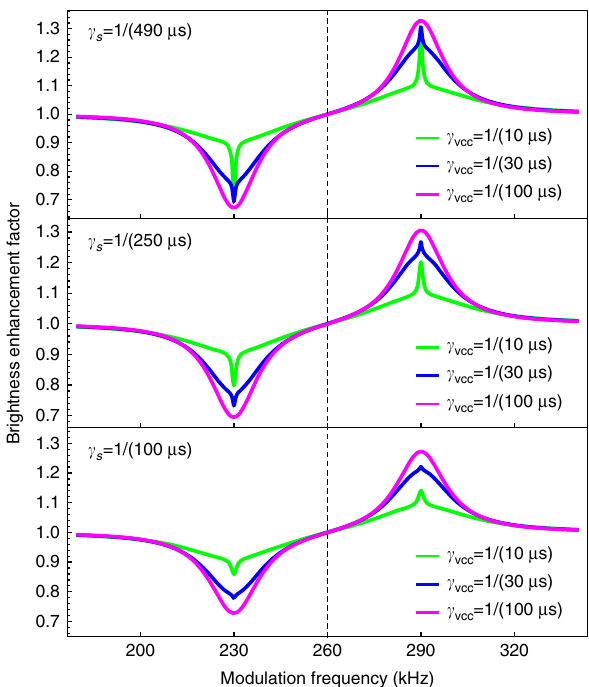
Fig. 6 Numerical modeling of the magneto-optical resonance. We assume a ¼ 15 W m − 2 in the mesosphere, and excursion of laser irradiance of I meso avg δ f = 30 kHz. The central dashed line indicates the Larmor frequency, γ denotes velocity-changing collision rates, and γ s spin-exchange collision